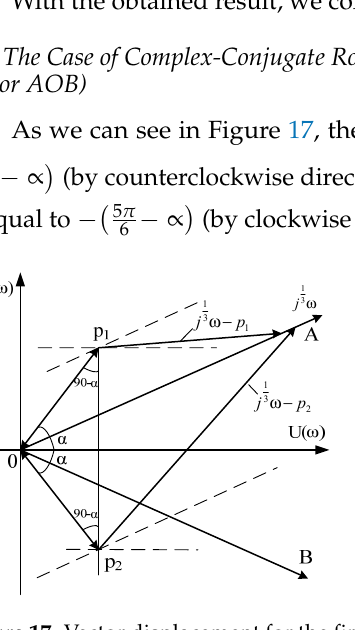
Figure 16. Vector displacement for the first two complex-conjugate roots for the case when 𝜔 𝜖 (0, ∞) . With the obtained result, we conclude that such a system is not stable.